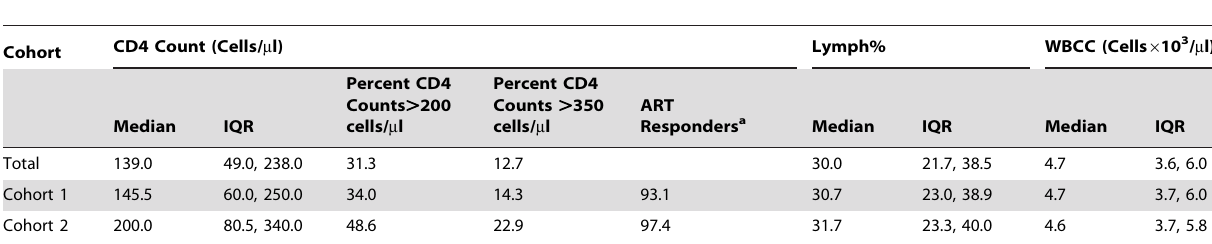
Table 2. Baseline